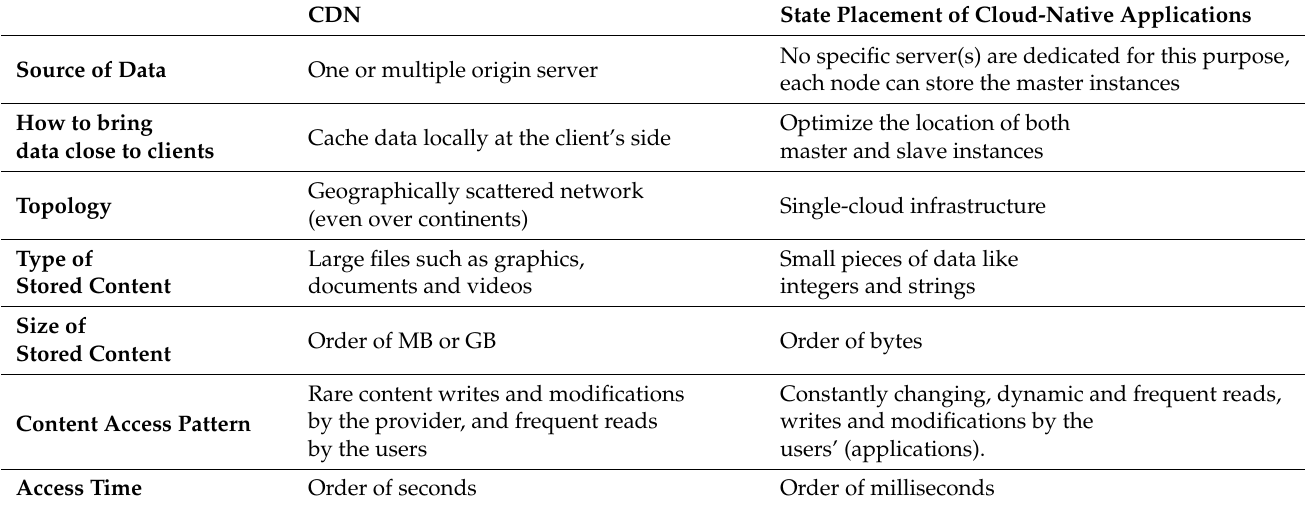
Table 1. Comparative analysis of CDN and the state placement problem of cloud-native applications. CDN State Placement of Cloud-Native Applications Source of Data One or multiple origin